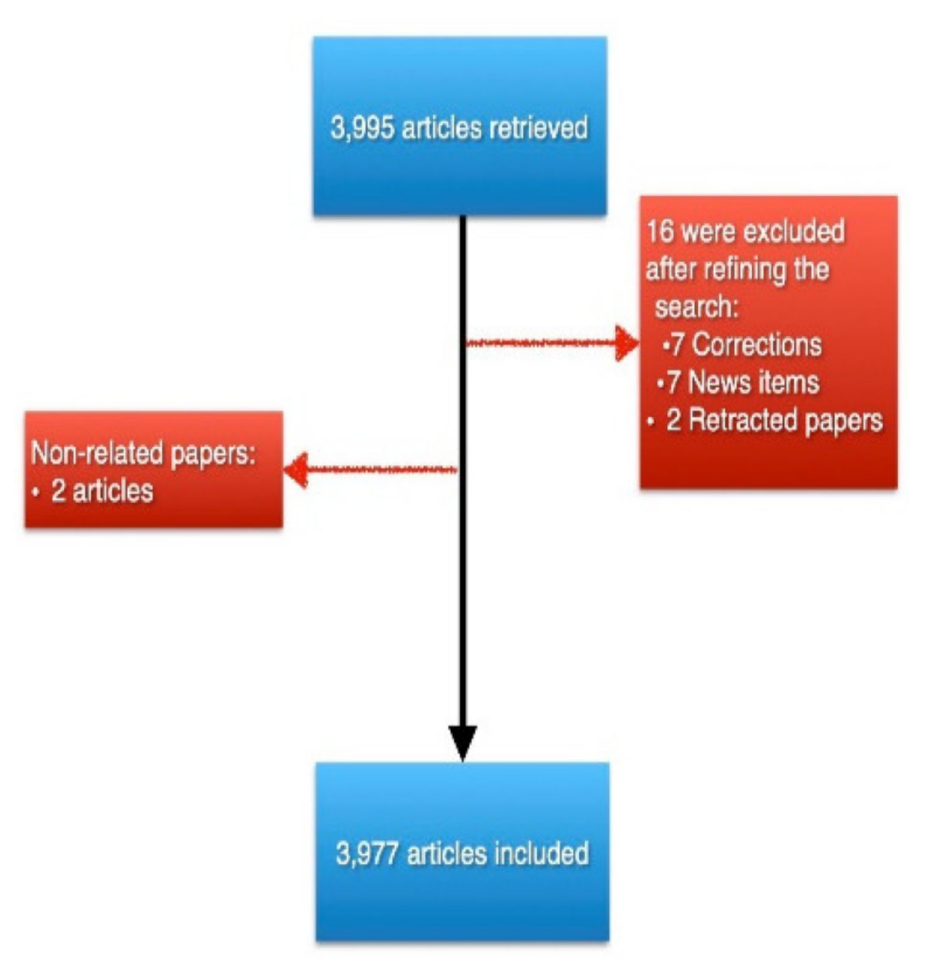
Figure 1. A PRISMA-like graph detailing the number of retrieved records and the resulted final included number after excluding